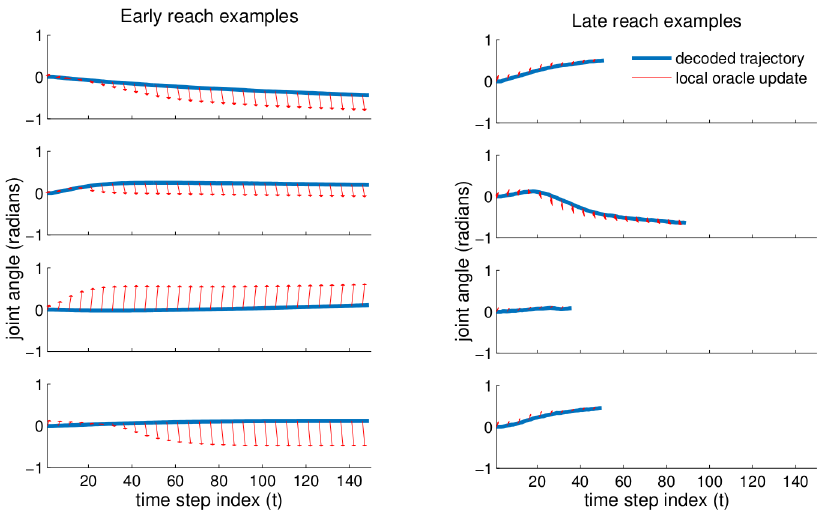
Fig 6. Plots depict reach trajectories of a representative shoulder DOF for 4 paired examples of reaches, from separate re-initializations of the decoder (i.e. different trials). Left panels show a poorly- performing early decoder (k = 2), and right panels show a well-performing decoder (k = 30). Rows correspond to matched pairs of reaches for different repeats of the experiment. Blue curves correspond to the actual decoded pose of the DOF over time, and red arrows depict the local oracle update (only visualized for a subsampling of timesteps). For the early reaches, observe that the decoder does not always proceed in the intended direction. For the late reaches, observe that actual pose updates are quite consistent with the oracle and trajectories are shorter because the targets are acquired more frequently and more rapidly.